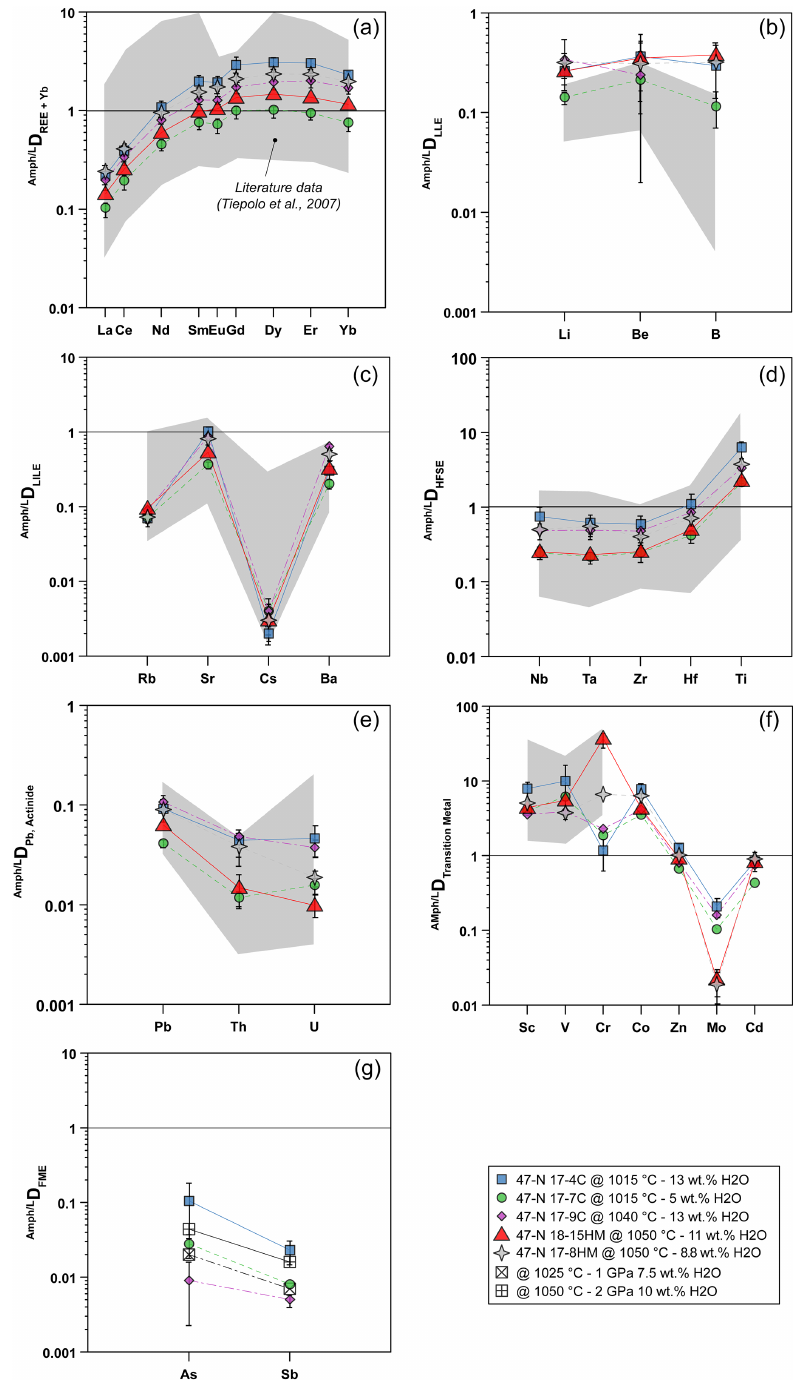
Figure 7. Amphibole–liquid partition coefficients ( Amph / L D) for different element groups: (a) REEs, (b) light lithophile elements (LLEs), (c) large ion lithophile elements (LILEs), (d) high field strength elements (HFSEs), (e) Pb and actinide, (f) transition metals, and (g) fluid- mobile elements (FMEs: As, Sb). Gray fields represent a compilation of data from the literature as previously documented by Tiepolo et al. (2007, and references therein) and Nandenkar et al. (2016). Black symbols in (g) refer to Amph / L D for As and Sb from Adam and Green (2006) performed at different P − T conditions (see legend) and are shown for comparison. When not visible, the error bar is smaller than the